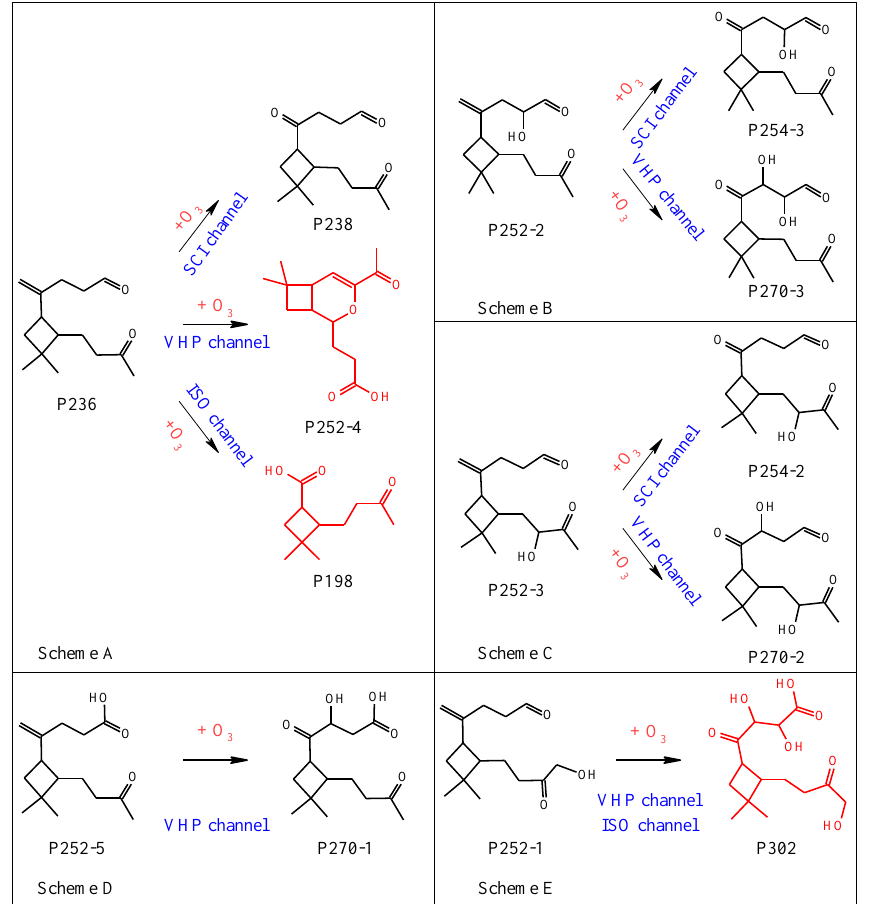
FIGURE 4 Fig. 4. Ozonolysis pathways from first- to second-generation products. The three new products identified in this study are shown in red. Reaction channels (blue): SCI, stabilization of Criegee intermediate (CI) by collision with gas-phase molecules (M) and subsequent reaction with H 2 O followed by loss of H 2 O 2 (cf. Fig. S4); VHP, formation and subsequent rearrangement of a vinyl hydroperoxide (cf. Fig. S4); and ISO, formation and subsequent isomerization of a product (cf. Fig. S5).